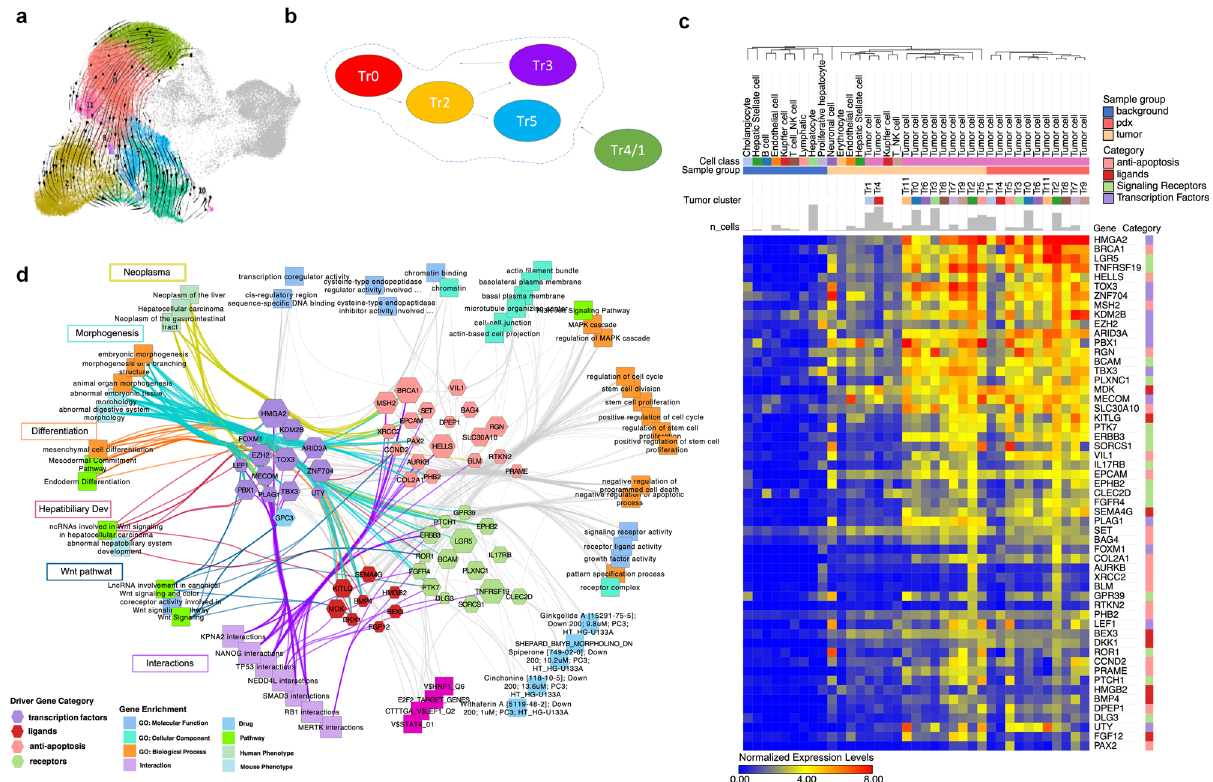
Fig. 6 De fi nition of cell-cluster progression and molecular targets. a RNA velocity of tumor clusters is shown on the UMAP. Streams indicate the predicted tumor transitions across clusters (Methods). We only focused on clearly identi fi ed clusters and removed clusters with low sequencing depth (Tr1 and Tr4) since RNA velocity is easily biased by technical noise 58 . b Diagram of proposed tumor cell cluster progression from precursor (Tr0) to initiating cells (Tr2) to progression (Tr5) and maintenance cells (Tr3) with integration of potential angiogenic/endothelial cell population (Tr4). c Heatmap of potential driver or targetable gene sets in tumor cells, background liver, and tumor environment. Differentially and highly expressed (maximal row levels are greater than 0.5) anti-apoptosis genes, ligands, and receptor genes and transcription factors in tumor cells are selected and shown (GO:0043066: negative regulation of apoptotic process; GO:0048018: receptor-ligand activity; GO:0004888: transmembrane signaling receptor activity; GO:0000976: transcription-regulatory region sequence-speci fi c DNA binding). Endo endothelial cells, Cho cholangiocytes, HSC hepatic stellate cells, Kup Kupffer cells, B B cells, NK NK cells, T T cells, Hep hepatocytes, Mono monocytes, T/NK T cells or NK cells. d Network showing driver genes ( c ) and associations with tumor-related terms enriched in ToppCluster. The size of hexagon indicates the gene expression level in tumor cluster Tr2. Key functional associations, such as morphogenesis and Wnt signaling pathway, are highlighted in different